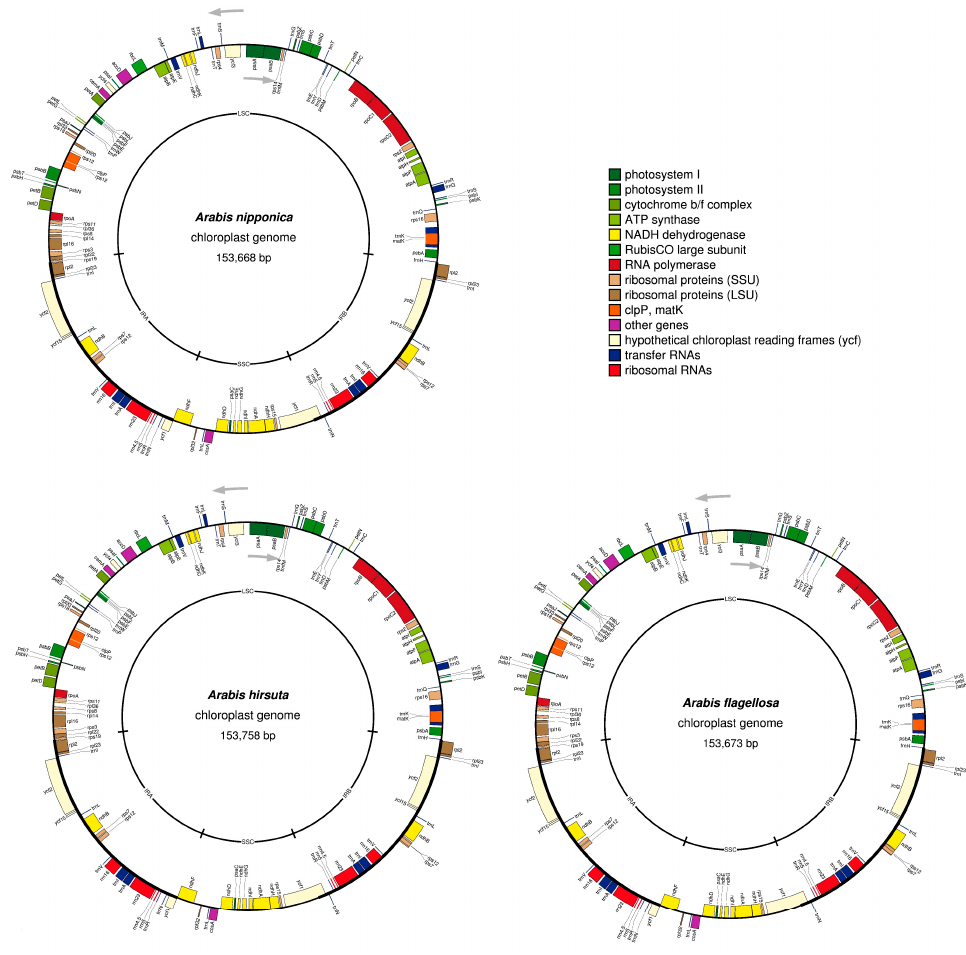
Figure 1. Chloroplast genome structure of Arabis species. Genes shown outside the map circles are transcribed clockwise, while those drawn inside are transcribed counterclockwise. Genes from different functional groups are color-coded according to the key at the top right. The positions of long single copy (LSC), short single copy (SSC), and two inverted repeat (IR: IRA and IRB) regions are shown in the inner circles.